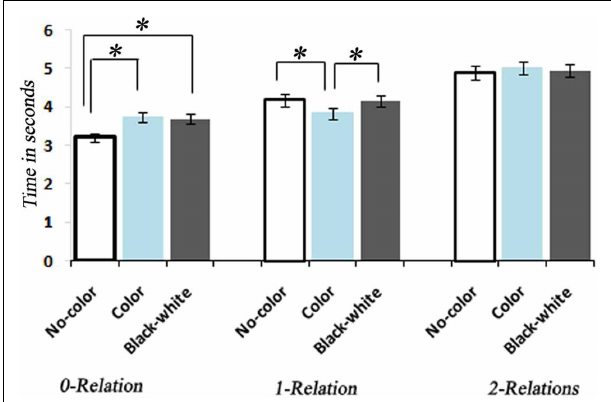
FIGURE 3 | Bar graph representation of response times associated with No-Color, Color, and Black-white Visual Contrast task itemsfor 0, 1, and 2 levels of relational complexity. ∗ , indicates a statistically significant difference between conditions.